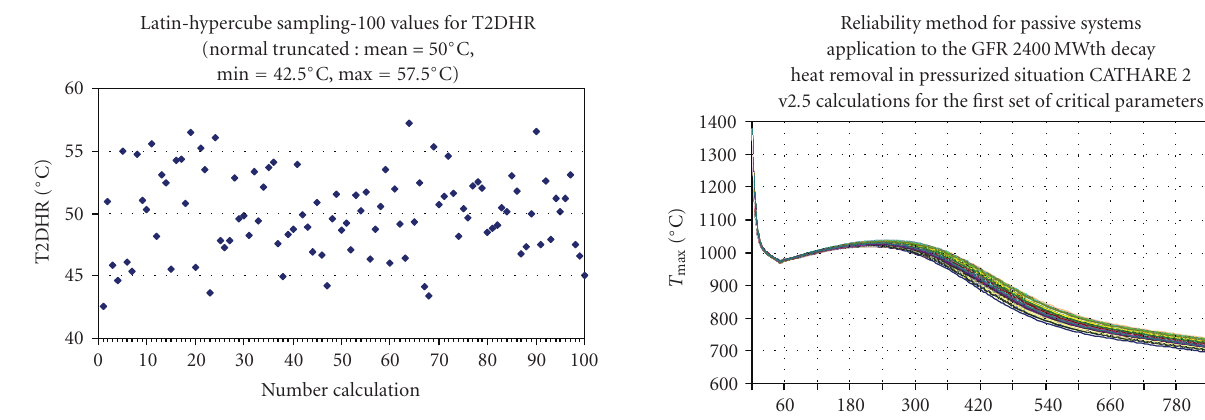
Figure 12: Optimized LHS (100 values for T2DHR).